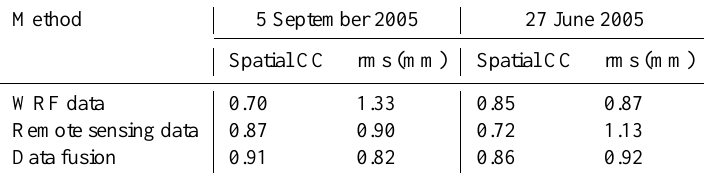
Table 2. Spatial correlation coefficients (CC) and rms values when comparing the prediction maps with MERIS PWV